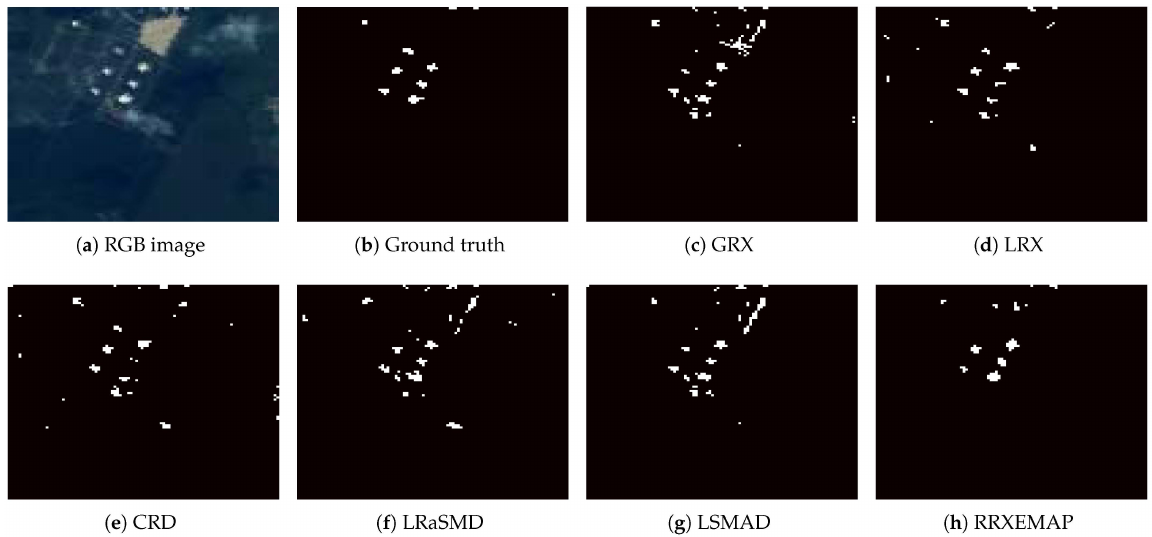
Figure 14. Color detection maps obtained by different algorithms for the abu-urban-1 dataset.